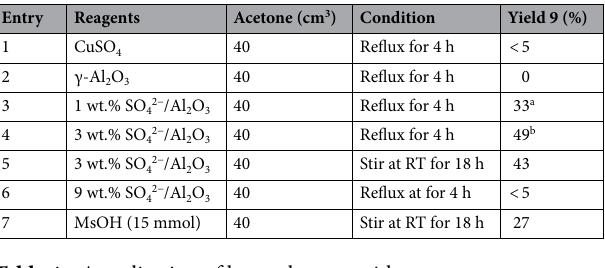
Table 4. Acetalization of lyxonolactone with